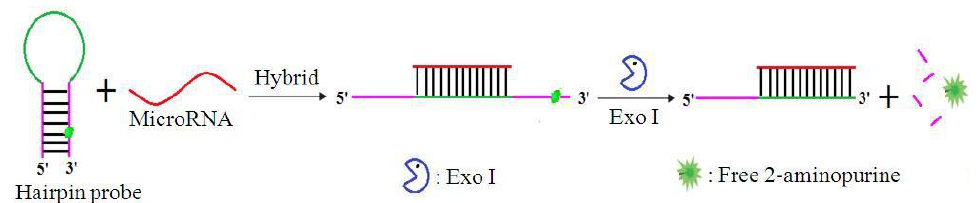
Figure 1. Schematic showing the principle of the quencher-free fluorescence-based method for the detection of microRNA. Exo I: Exonuclease I.